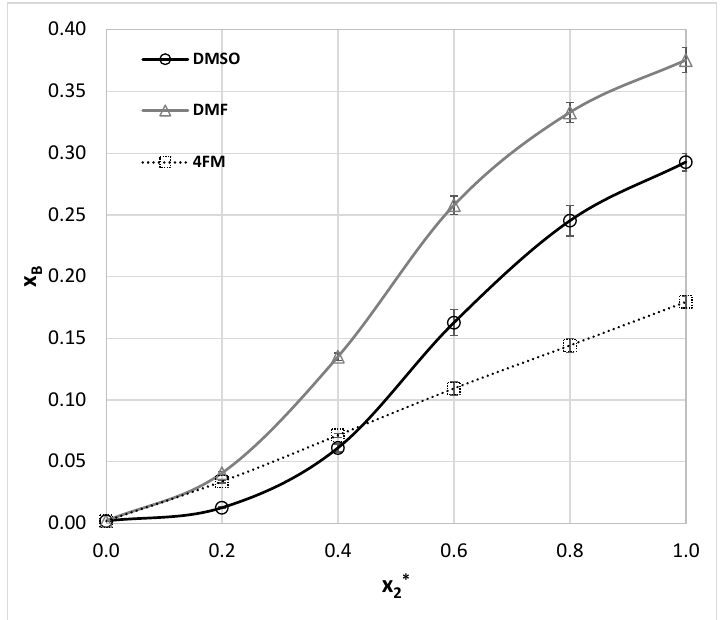
Figure 3. The results of benzamide solubility measurements (molar fraction, x B ) at room temperature in aqueous DMSO, DMF, and 4FM mixtures (x 2 * stands for the organic component mole fraction in the binary solvent). The error bars denote standard deviation values ( n = 3).